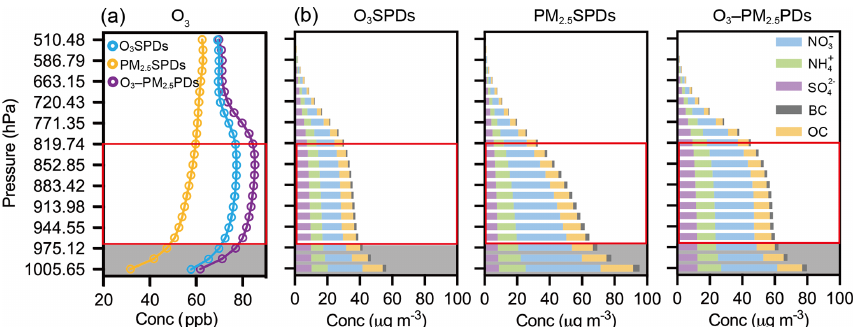
− , NH + , SO 2 − , BC, OC 3 4 4